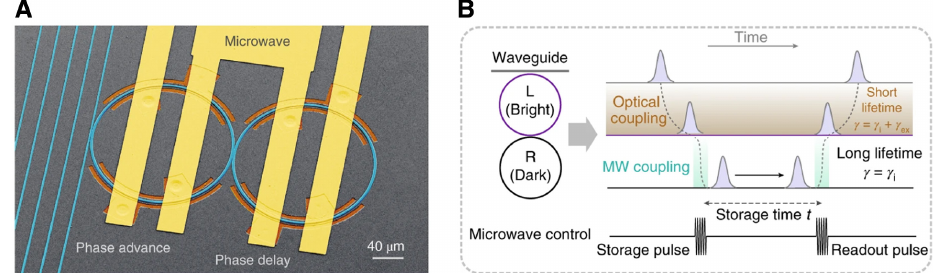
Figure 25: Electronically programmable photonic molecule. (A) False-colored scanning electron microscope image of the coupled microring resonators, (B) operating principle of on-demand storage and retrieval of light based on a photonic dark mode. Reprinted by permission from Zhang et al. [75], Springer Nature Limited, copyright 2019.